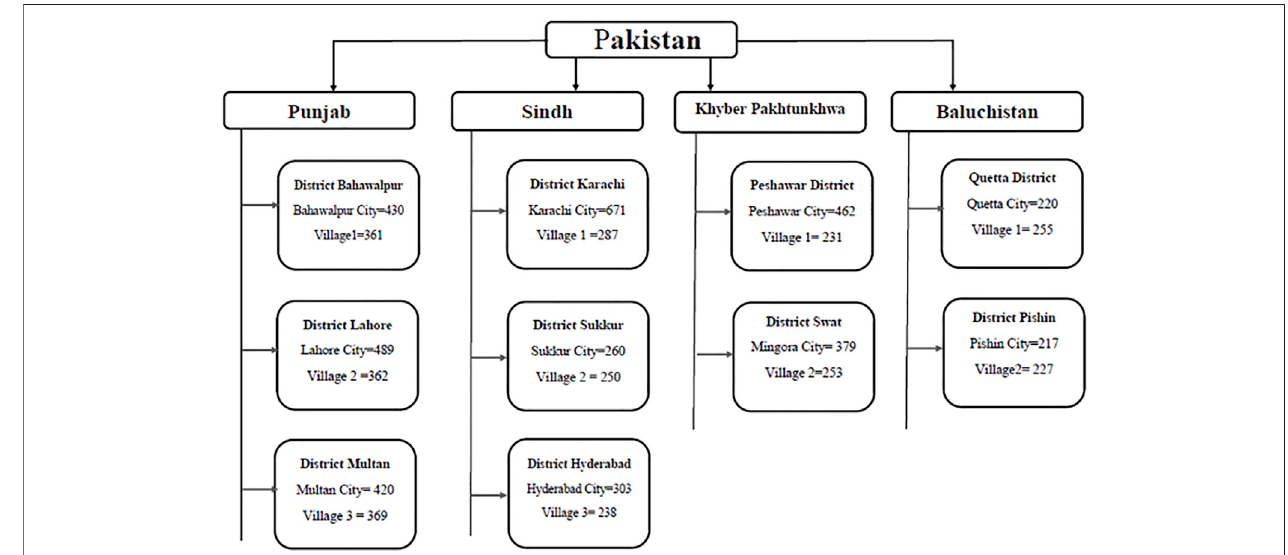
FIGURE 1 | Selection of study area.